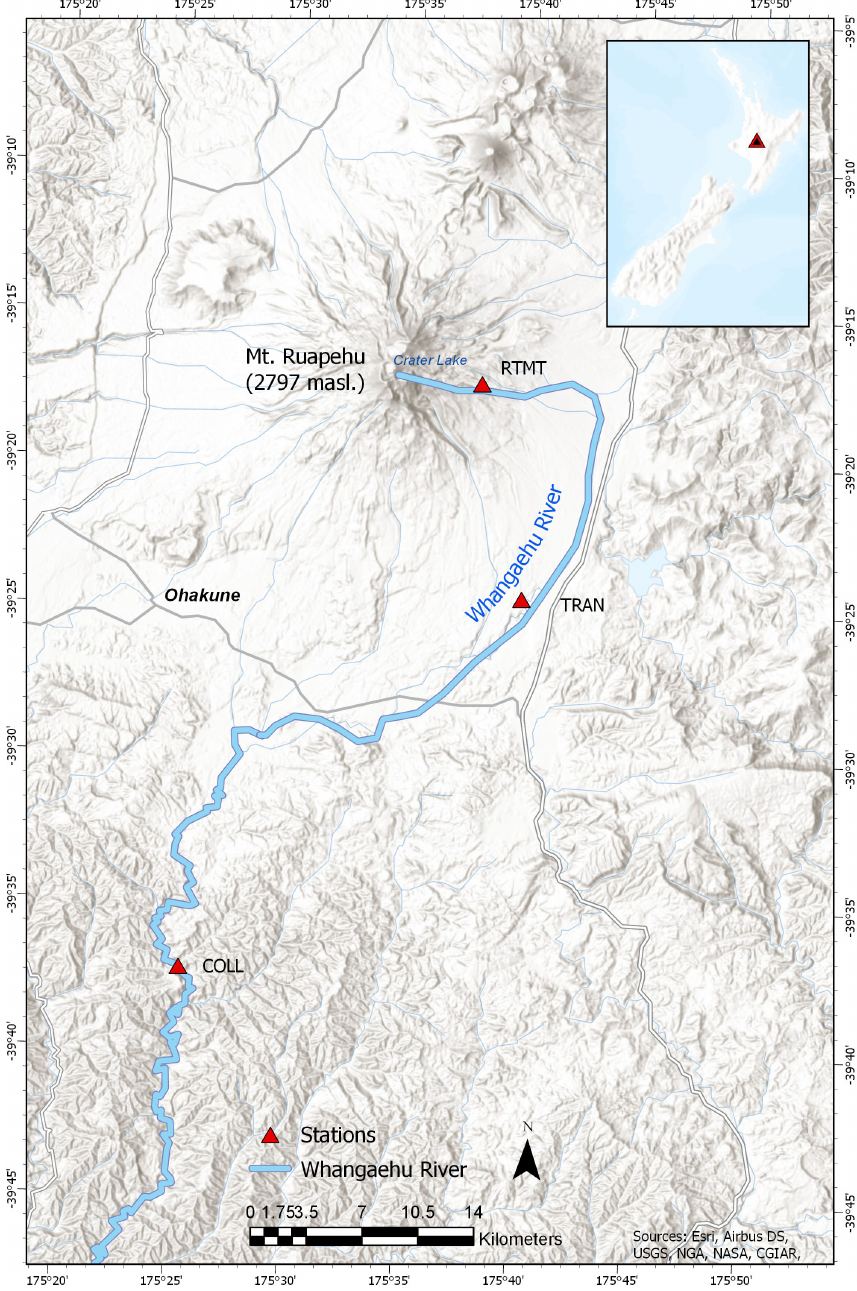
Figure 1. Map of Mt. Ruapehu and the surrounding area located on the central North Island of Aotearoa/New Zealand. The blue outline represents the Whangaehu channel and the path the 18 March 2007 lahar traveled down. Red triangles denote the three monitoring stations along the Whangaehu channel at 7.4, 28, and